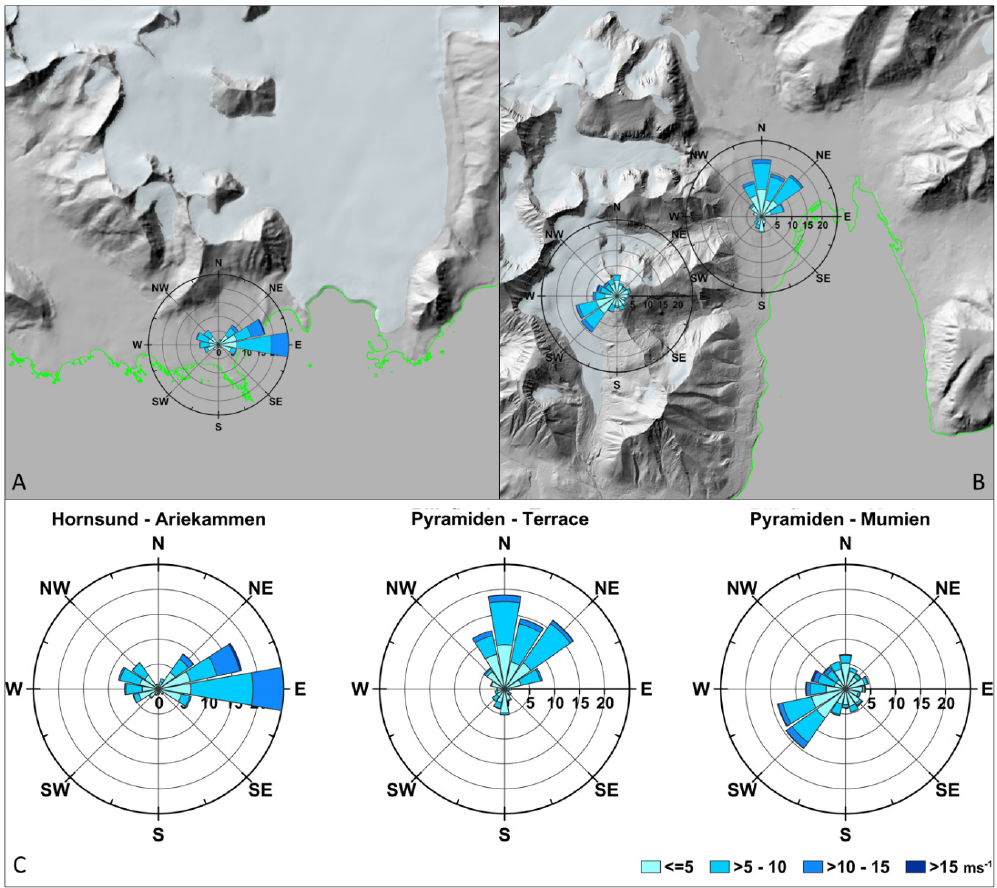
Figure 5. Wind roses based on observed surface winds plotted in their exact positions within the study areas–Hornsund ( A ), Petuniabukta ( B ); Detailed wind roses at Hornsund (10 m a.s.l.), Terrace station near Pyramiden (14 m a.s.l.) and top of the Mumien Peak (764 m a.s.l.) next to the Pyramiden mountain ( C ) in the period 1 March–4 July 2019. The observations of cloud base height at Hornsund Polish Polar Station (1 March–26 June 2019) revealed three most frequent situations. The cloud base at 800 m a.s.l. was the most frequent (20% of the time), the second most frequent cloud base height was 300 m a.s.l. (16.5% of the time), the 1000 m a.s.l. being the third with 10.5% frequency (Figure 6). The 300 m altitude cloud base height was also often accompanied by precipitation. The other situations did not exceed 10% of occurrence.